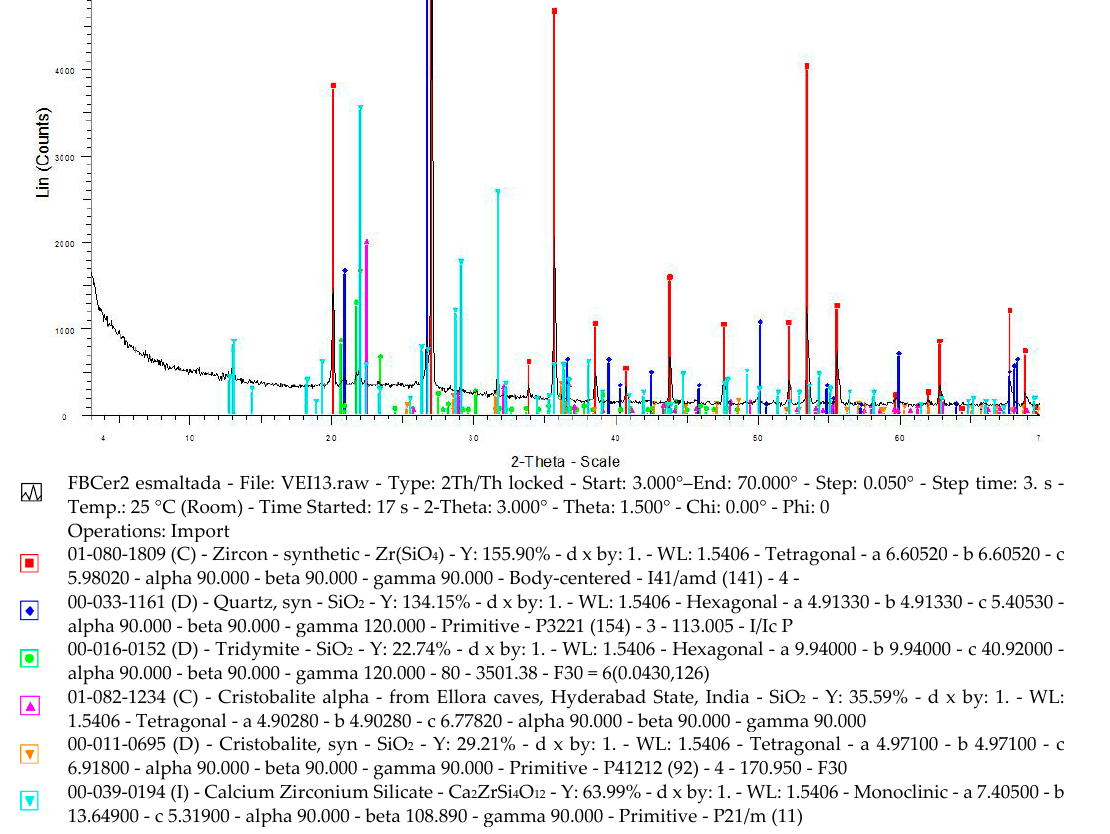
Figure 14. XRD DRX of the final layer of the ceramic tile glaze.